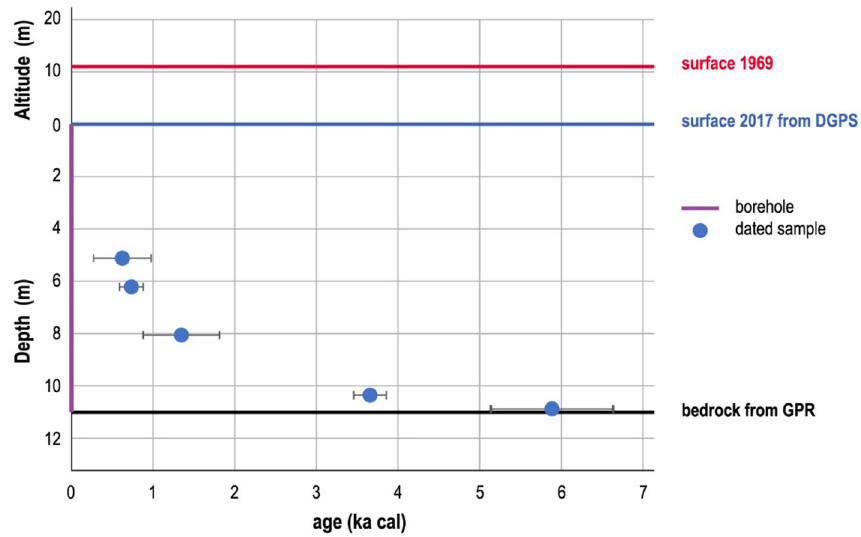
Figure 2. Depth-age relation of the Weißseespitze ice core, obtained by aerosol-based micro-radiocarbon dating of the ice. Also shown is the reconstructed surface elevation loss between 1969 and 2017. Figure made with licensed software Adobe Illustrator CS6 (https ://www.adobe .com).